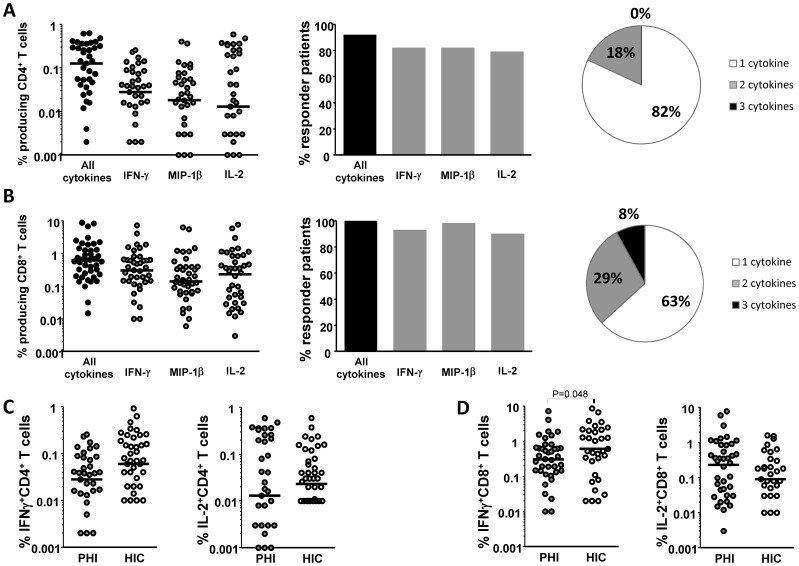
Similar HIV-specific T cell responses in PHI-patients and HIC.
A. PHI patients: frequency of CD4+ T-cells producing at least one cytokine (IFN-γ, MIP-1β or IL-2) in response to HIV-p24 stimulation, as determined by ICS (left); percentage of patients with a positive CD4+ T-cell response (centre); and frequency of HIV-specific CD4+ T-cells producing one, two or three cytokines (right) B. same experiments with CD8+ T-cells challenged with MHC-matched optimal HIV-1 peptides. C. Comparative frequency of IFNγ- (left) and IL2 (right)-producing CD4+ T-cells in PHI patients and HIC. D. Idem for CD8+ T-cells. Each symbol represents one individual. Medians are shown as horizontal lines.